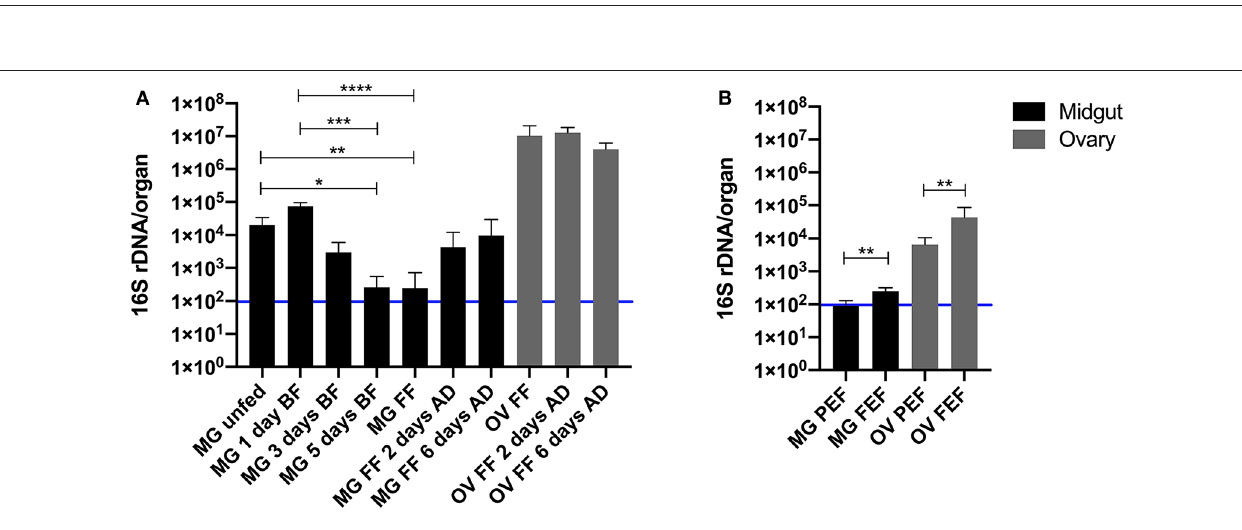
Frontiers in Cellular and Infection Microbiology | www.frontiersin.org